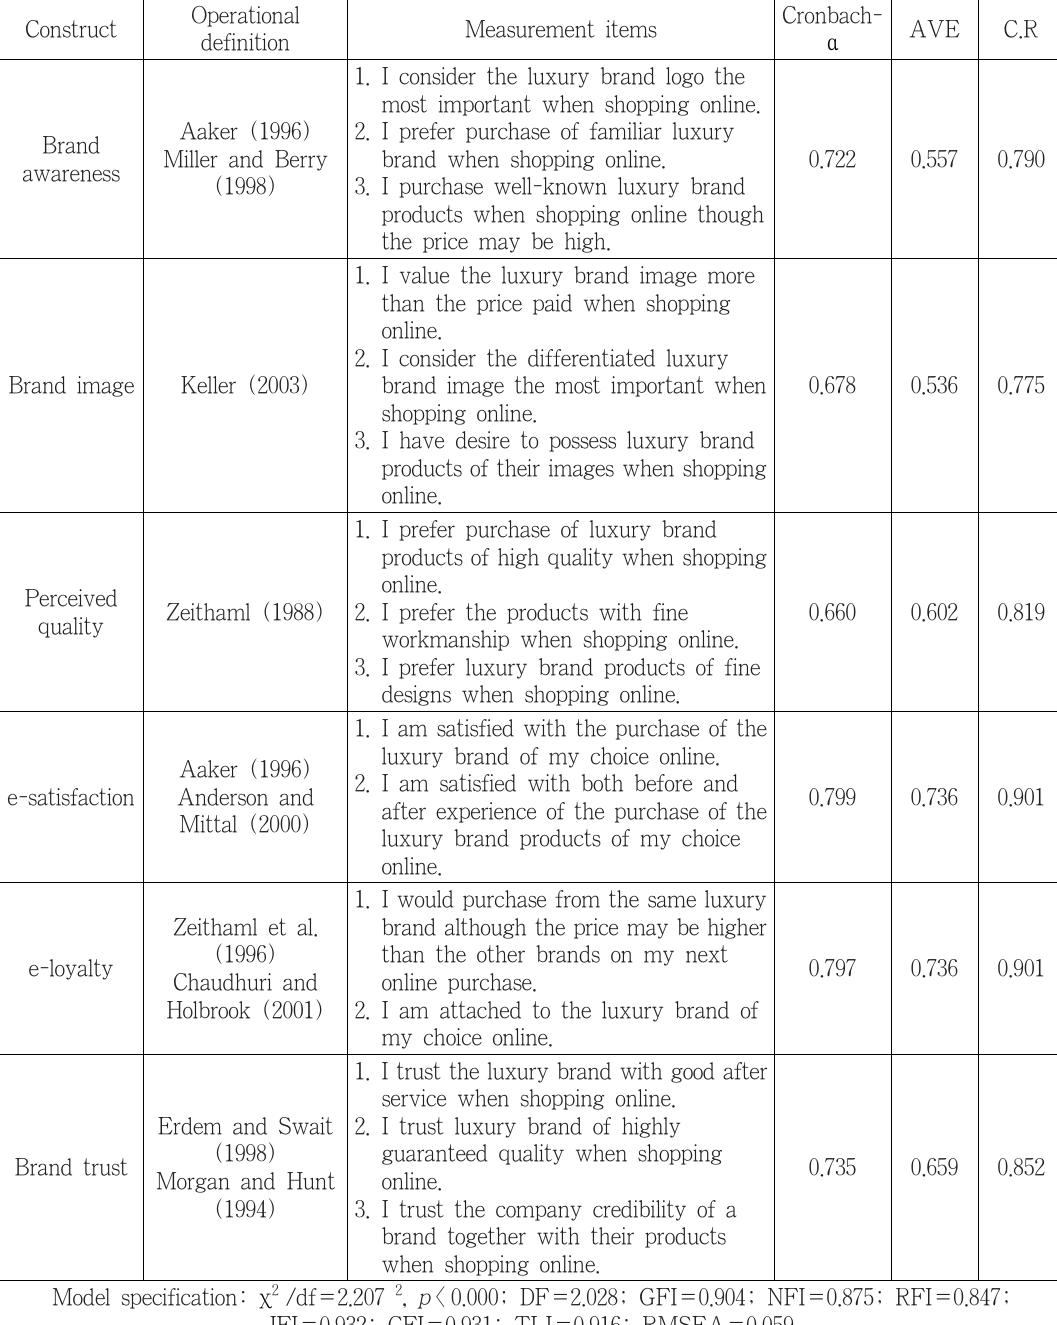
<Table 1> Measurements of Variables and Reliability and Validity